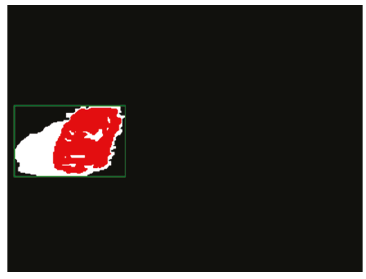
Figure 24: The result of dilation operations on Figure 23(b).